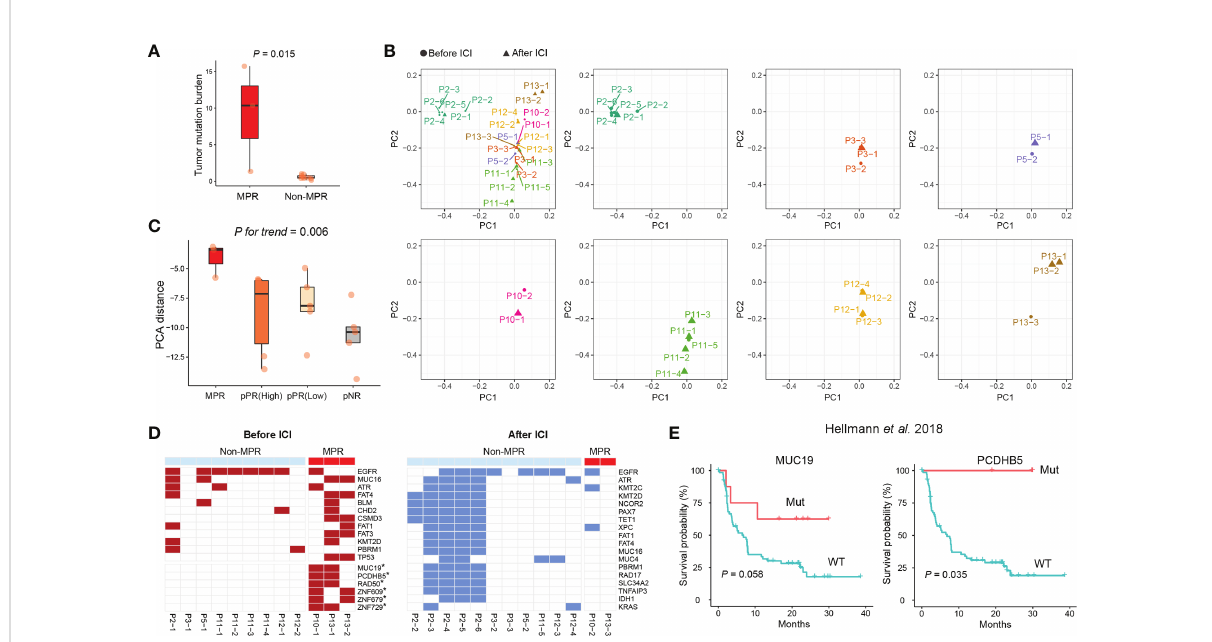
FIGURE 4 Mutational features of sMPLC before and after ICI immunotherapy. (A) Comparison of TMB between GGOs with and without MPR. (B) Genomic features of all analyzed GGOs among included patients. (C) Distinct genomic differences among GGOs with MPR, pPR, and pNR. (D) Frequent somatic mutations among GGOs with MPR before (left panel) and after (right panel) the use of ICI. (E) Kaplan-Meier curves using an independent cohort to estimate the prognosis of MUC19 - and PCDHB5 - mutated cases after immunotherapy. MPR, major pathologic response; pPR, pathologic partial response; pNR, pathologic nonresponse; ICI, immune checkpoint